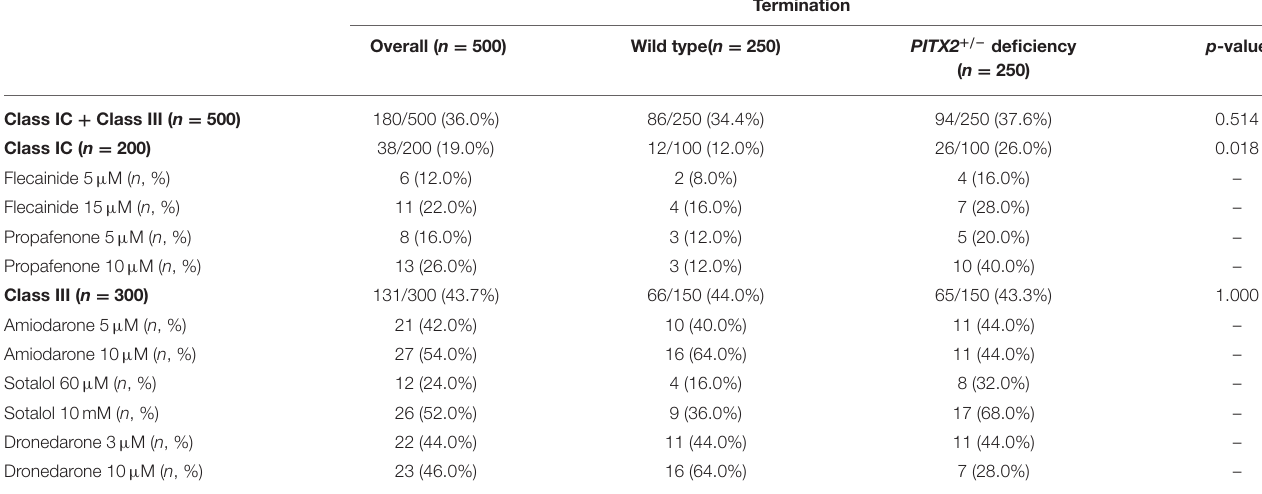
TABLE 5 | Termination results based on the wild-type and PITX2 + / −